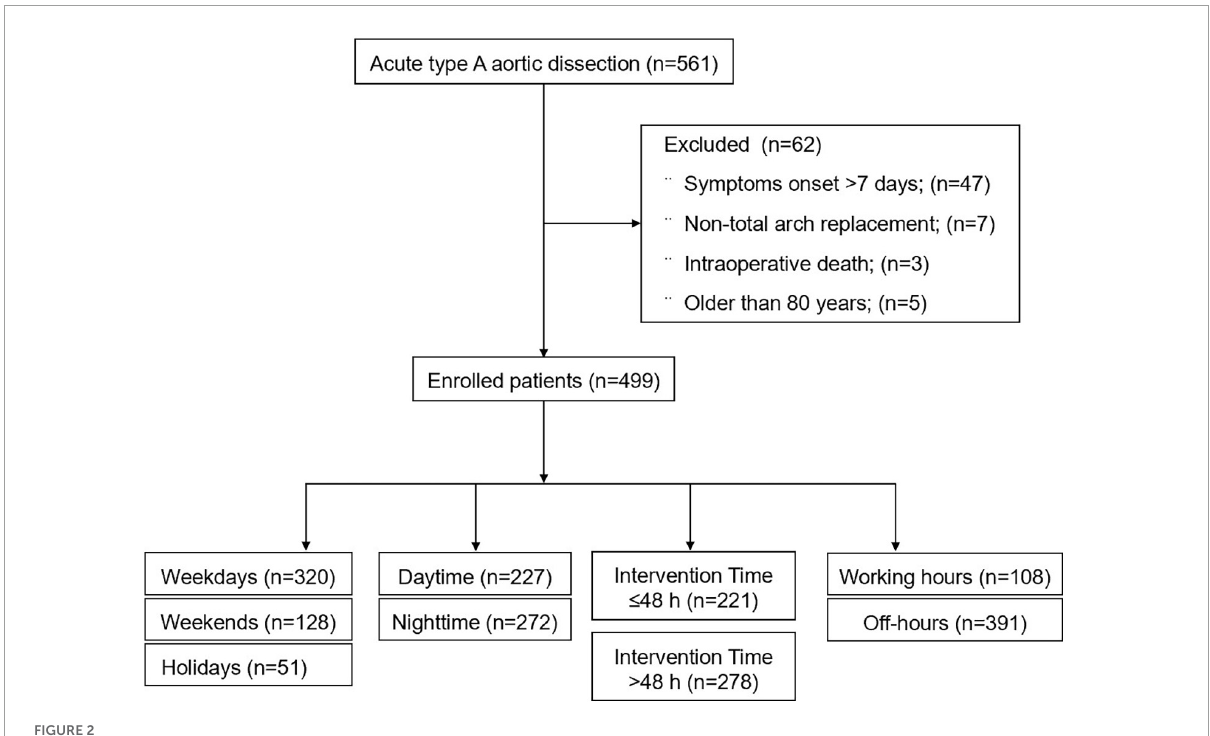
FIGURE2 Study flow